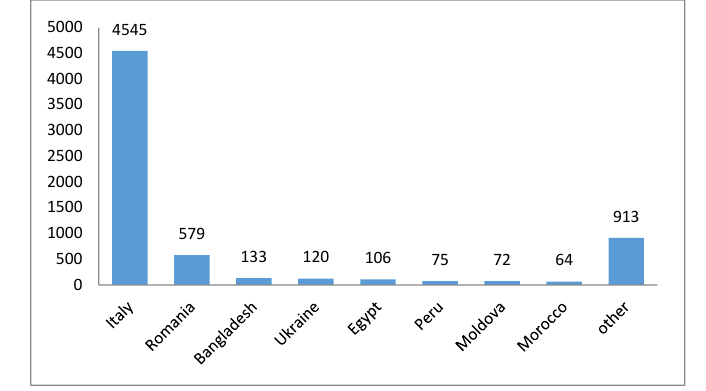
Figure 1. Reported nationality of the patient.